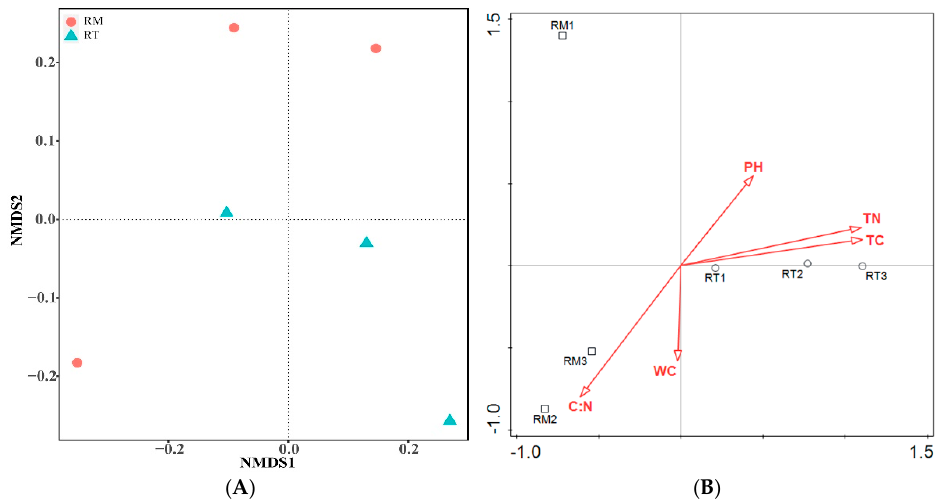
Figure 6. Nonmetric multidimensional scaling (NMDS) analysis of soil bacterial community ( A ) and Redundancy analysis ( B ) based on Bray–Curtis distance. The numbers 1, 2, 3 are repetitions in the same treatment. Significance test of the correlation between environmental factors and bacterial community